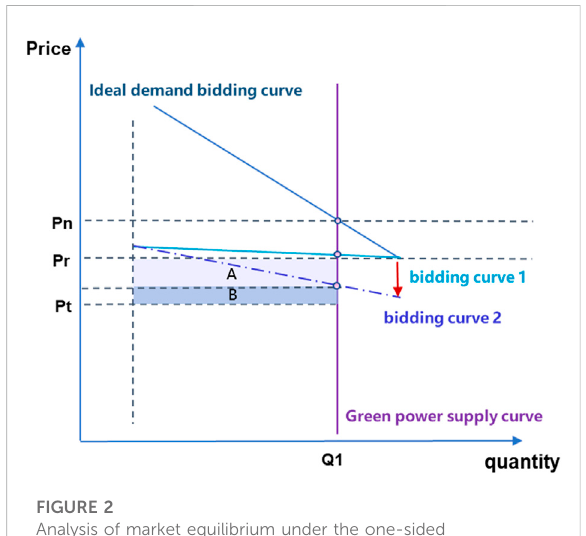
FIGURE 2 Analysis of market equilibrium under the one-sided customers ’ centralized bidding